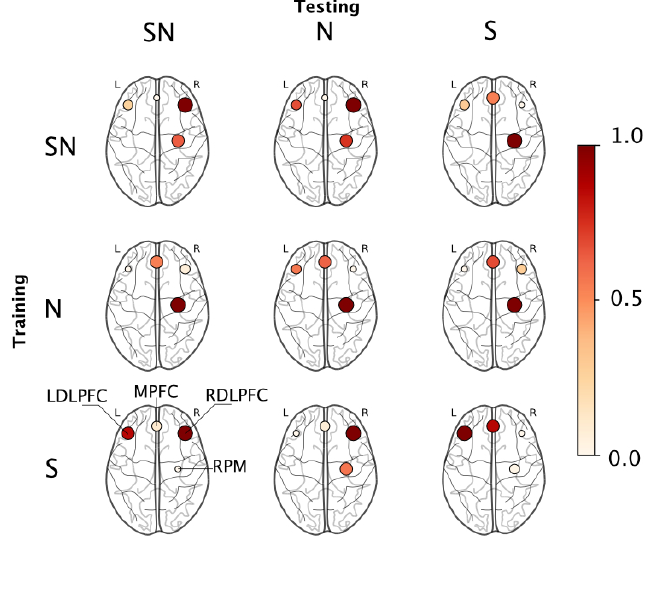
Figure 6. Permutation importance maps for each train-test combination reported in Table 4. The val- ues are normalized with node color and size indicating the relative contribution of each